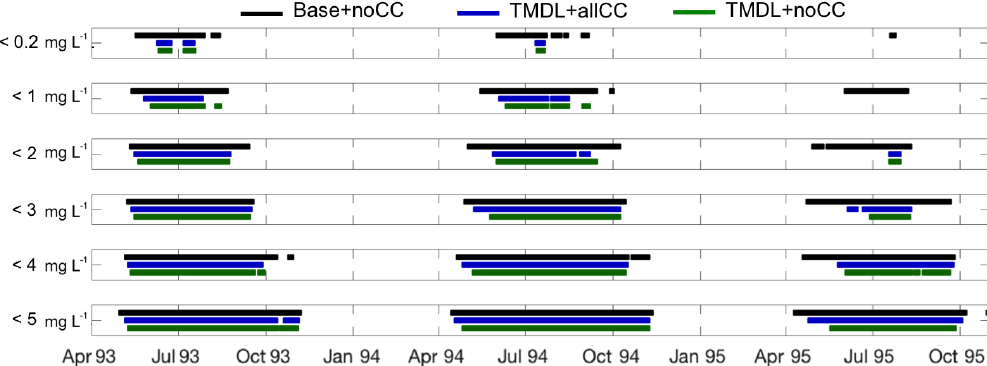
Figure 7. Bars showing duration of hypoxic volume (>1km 3 ) at each DO level for the Base + noCC run and the TMDL + noCC and TMDL + allCC nutrient scenarios.